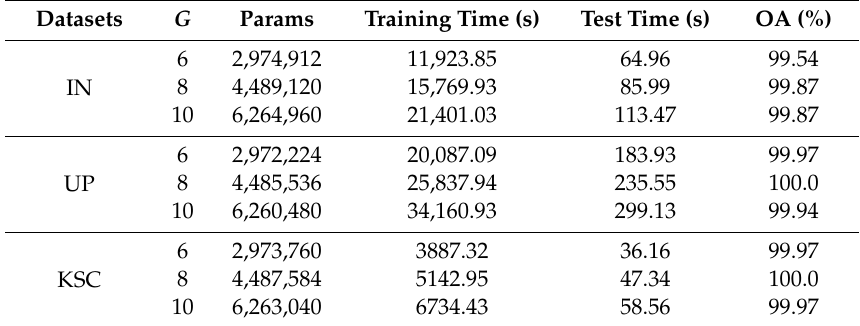
Table 10. Params, training time, test time, and OA for di ff erent numbers of groups G on the IN, UP, and KSC